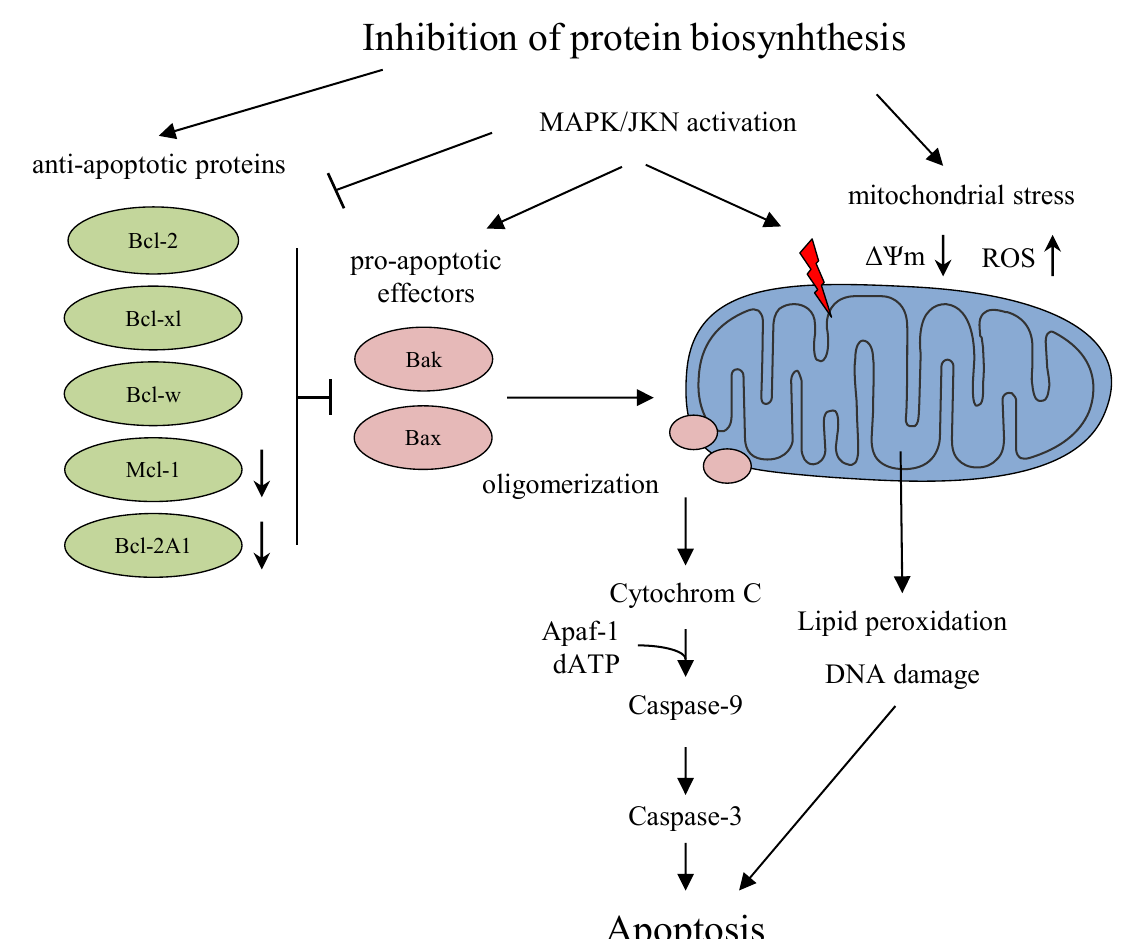
Figure 2. Proposed mechanisms by which targeted toxins induce apoptosis in cancer cells after inhibition of protein biosynthesis. ↑ upregulation; ↓ , downregulation.